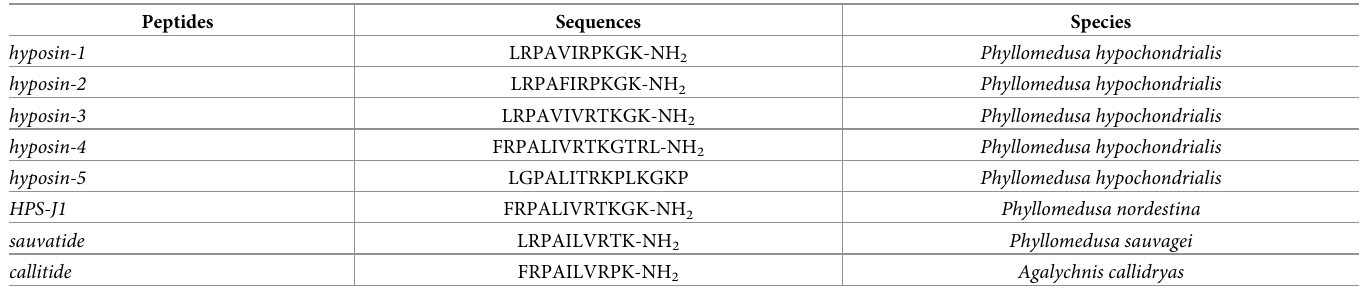
Table 1. Alignments of mature peptide sequences and origin